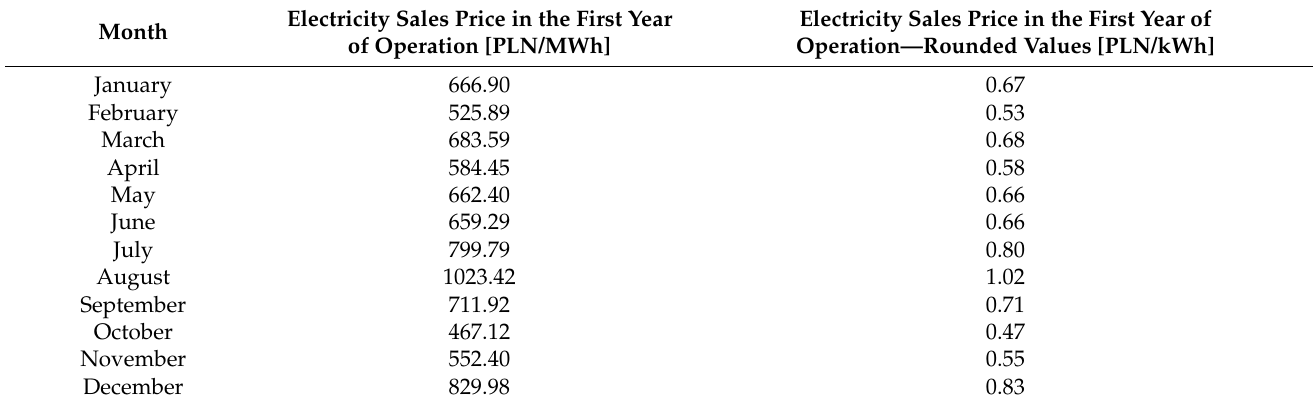
Table 4. Monthly sales prices for the electricity produced from the photovoltaic installation in the first year of the system’s operation